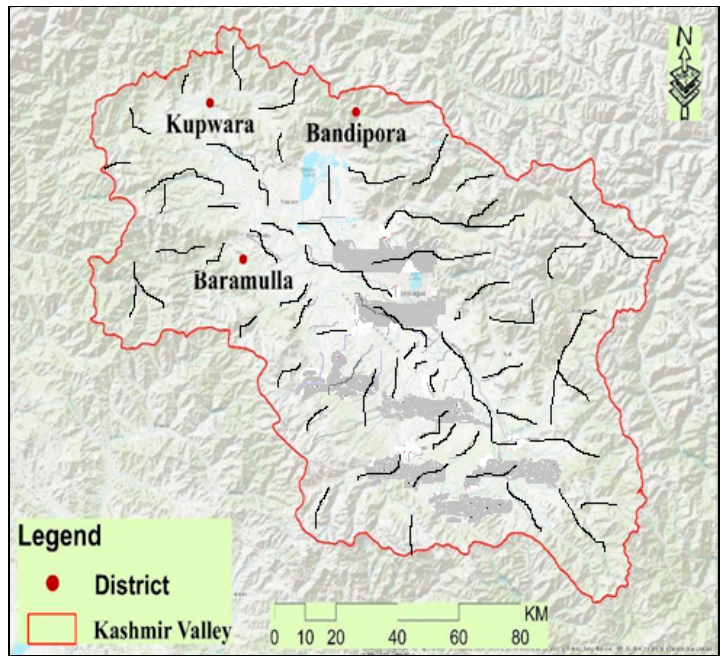
Figure 1. Map highlighting the broader areas surveyed. Table 1. Demographic status of respondents from North Kashmir Himalayas. Demographic Features.